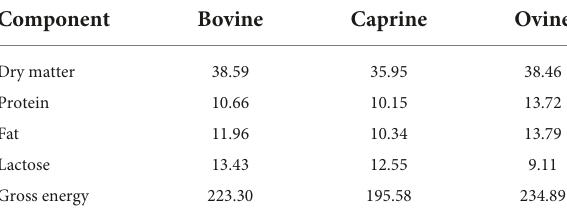
TABLE 2 Amounts (g/kg of BW per pig) of bovine, caprine, and ovine whole milk ingested per